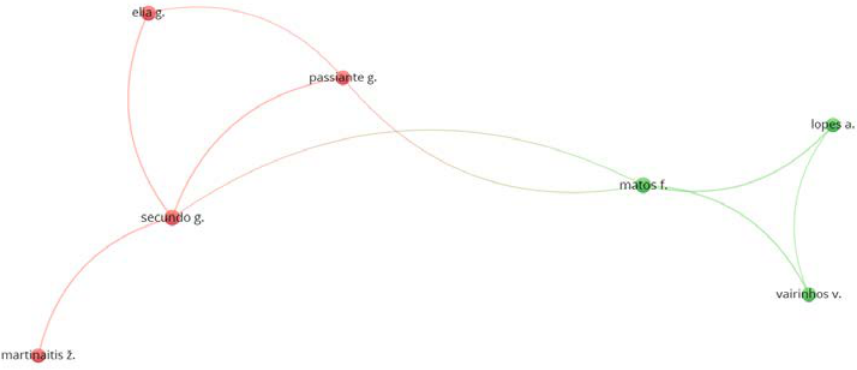
Figure 12. Collaboration networks between authors.